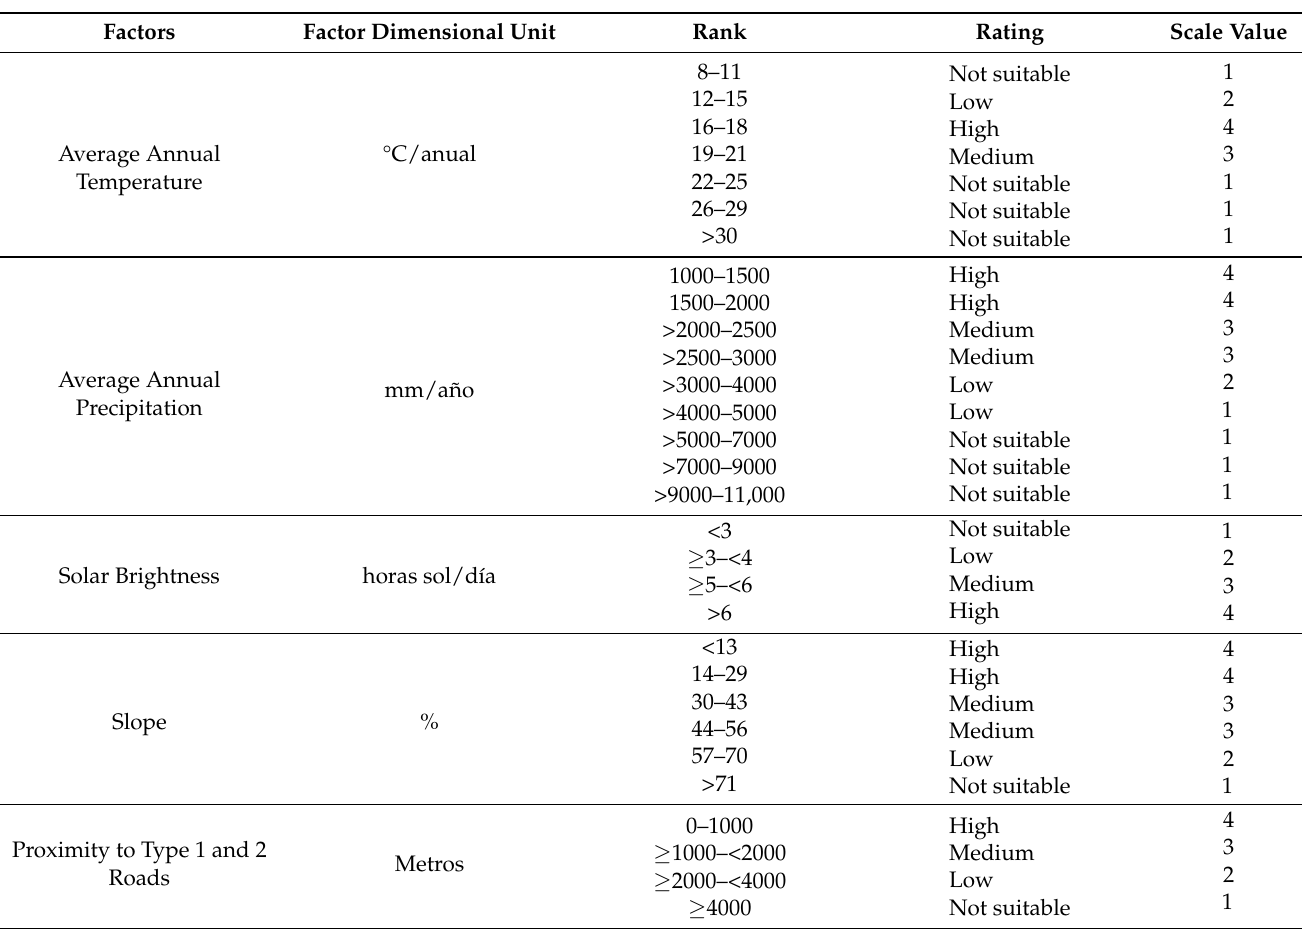
Table 3. Rating and scale assignment of suitability